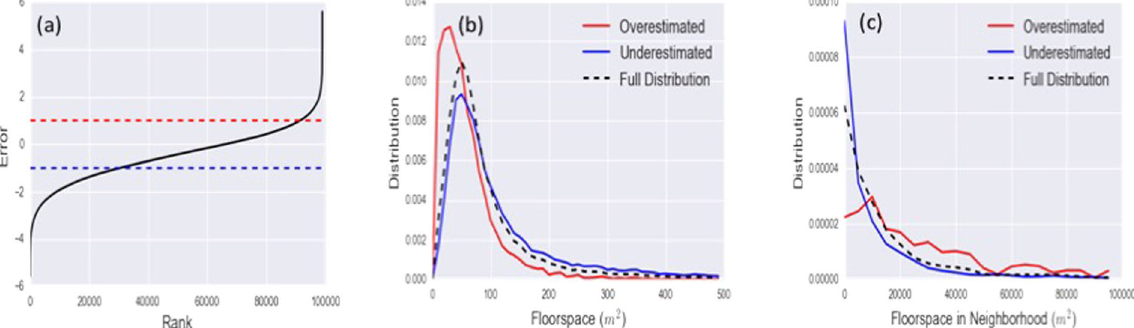
Figure 4. In this figure we present the results obtained analyzing the model’s errors in estimating the retailers’ success . In ( a ) we have ordered the errors by rank. The red and blue dashed lines indicate the thresholds we have used to define the subset of overestimated and underestimated retailers. In ( b , c ) we show that the overestimated retailers tend to be smaller than average with more floor-space than average in their